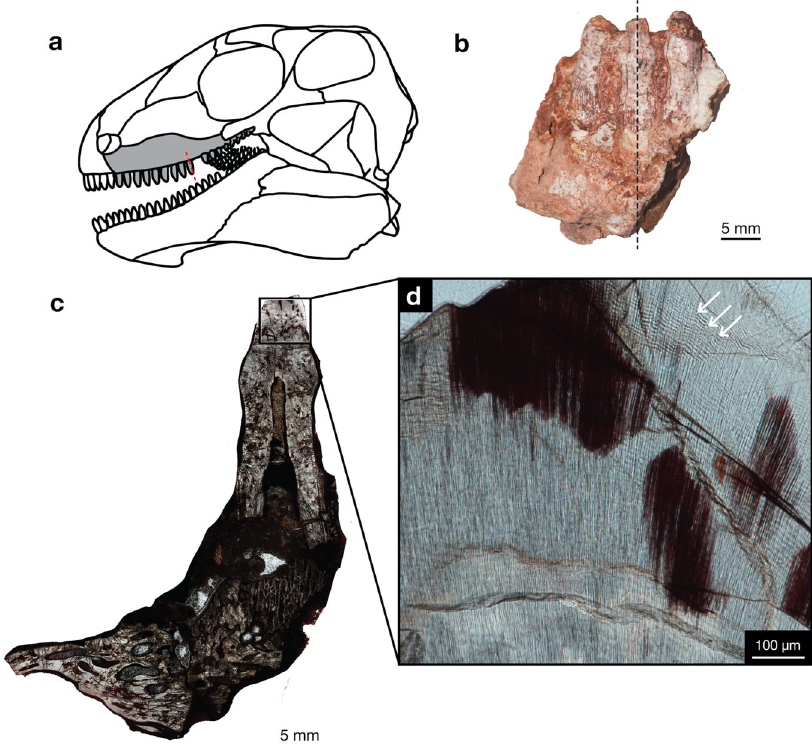
Fig. 4 | Incremental lines of Edaphosaurus sp. a Lateral view of Edaphosaurus . b USNMPAL706602,maxillarytoothfamily,photographedinlingualviewshowing the plane of LL section through the functional tooth and replacement tooth. c Whole view of longitudinal LL section near crown apex of functional and